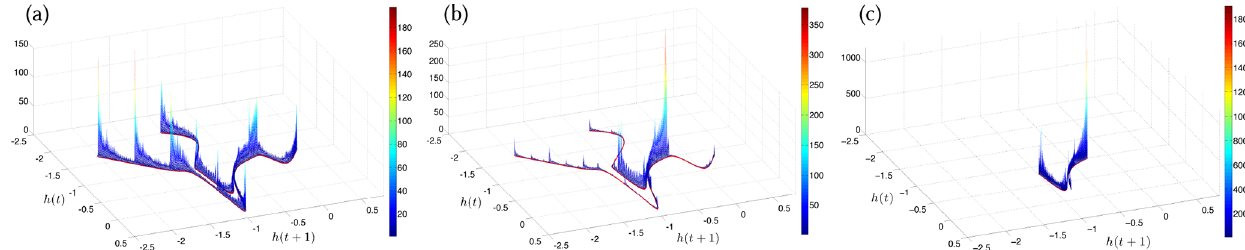
Figure 4. Critical transition in extreme event distribution in an idealized El Niño–Southern Oscillation (ENSO) model. The invariant, time- dependent measure, µ t , supported on the PBA of the ENSO delay differential equation (DDE) model of Tziperman et al. (1994), is plotted here via its embedding into the (h(t),h(t + 1 )) plane for a = ( 1 . 12 + δ))/ 180 and t (cid:39) 147 . 64yr and, respectively, (a) δ = 0 . 0, (b) δ = 0 . 01500, and (c) δ = 0 . 015707. The red curves in the three panels represent the singular support of the measure. Reprinted with permission from Chekroun et al.